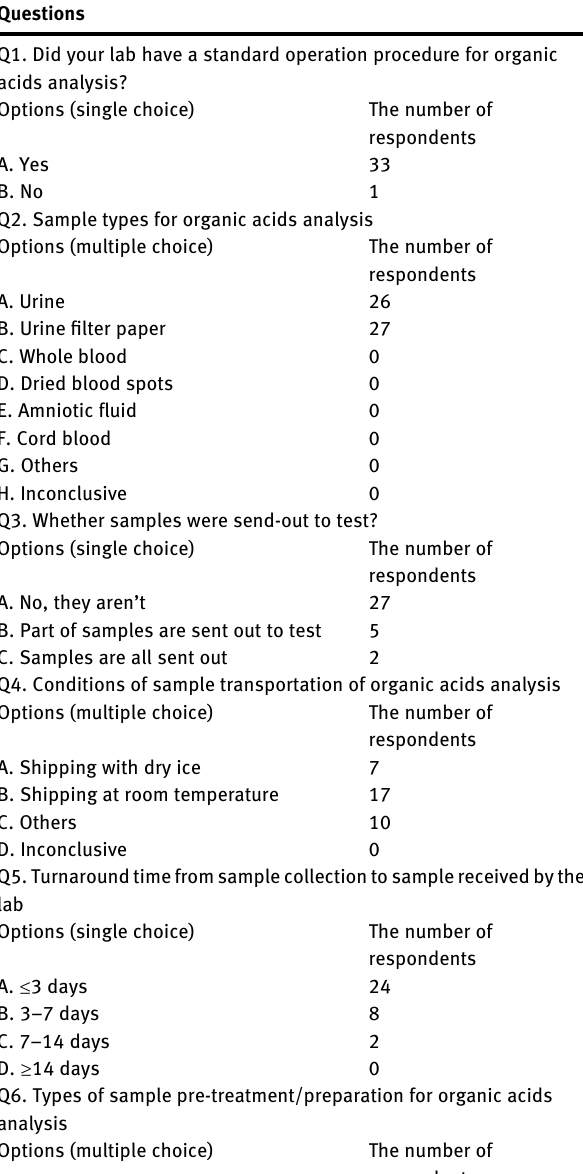
Table  : Total analytical process of organic acids